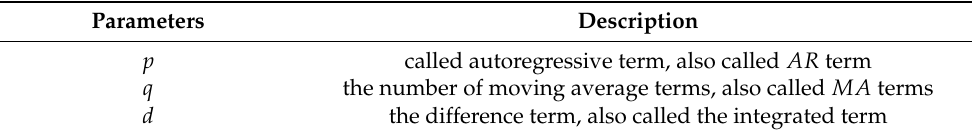
Table 2. List of parameters.